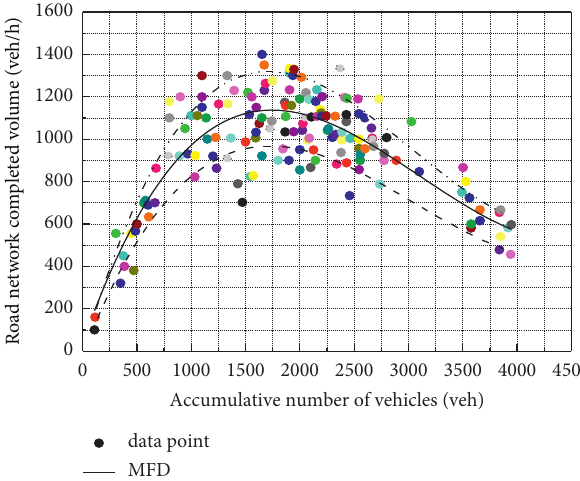
Figure 9: MFD fitting diagram of controlled